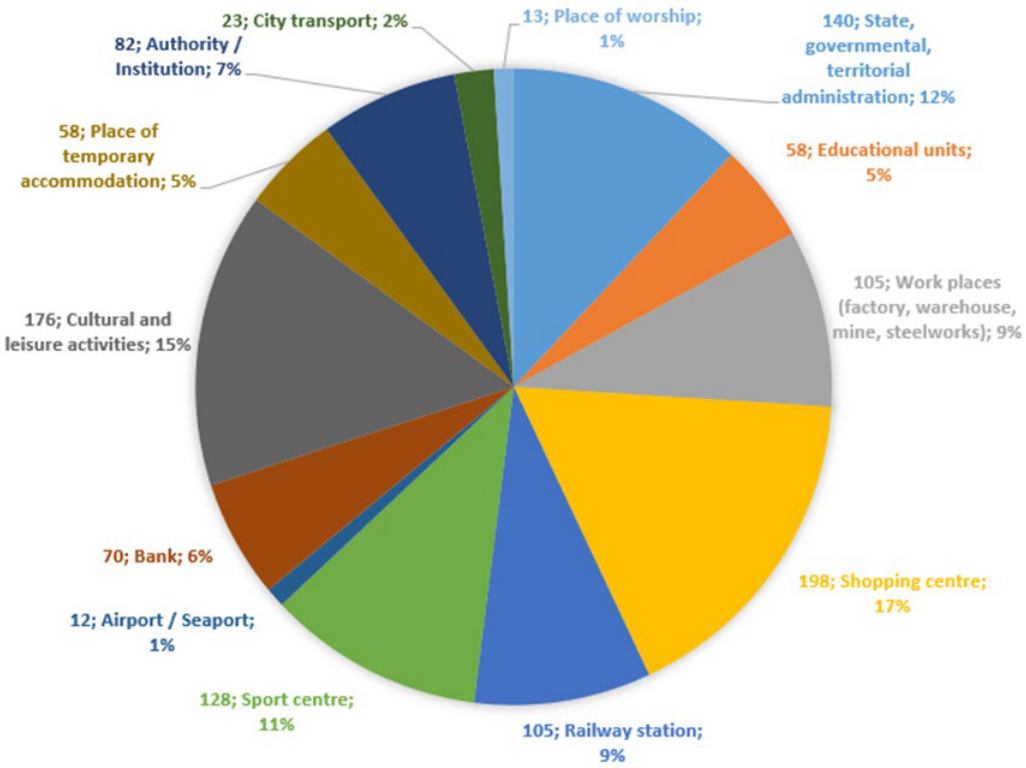
Figure 1. Profile of the location of AED devices ( n = 1165).